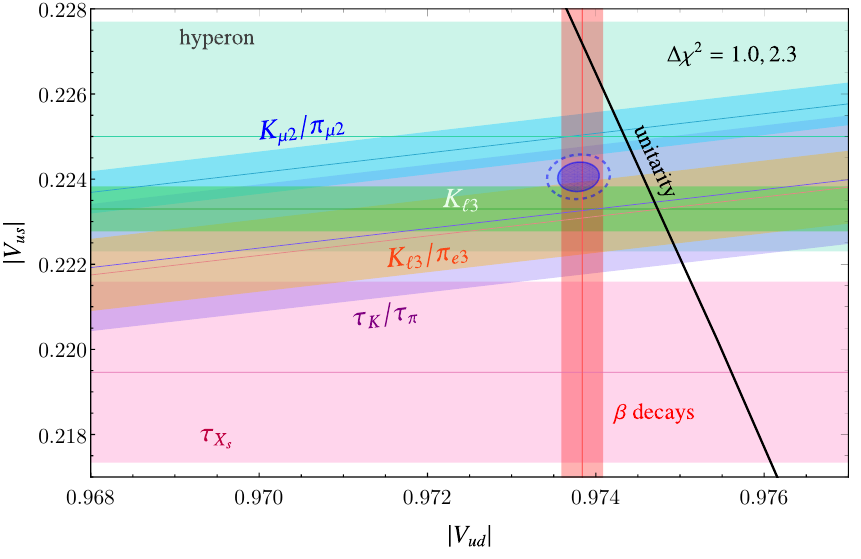
Figure 4 . Same as figure 3, but the 1 σ regions of | V us | hyperon , | V us | τ ables are also